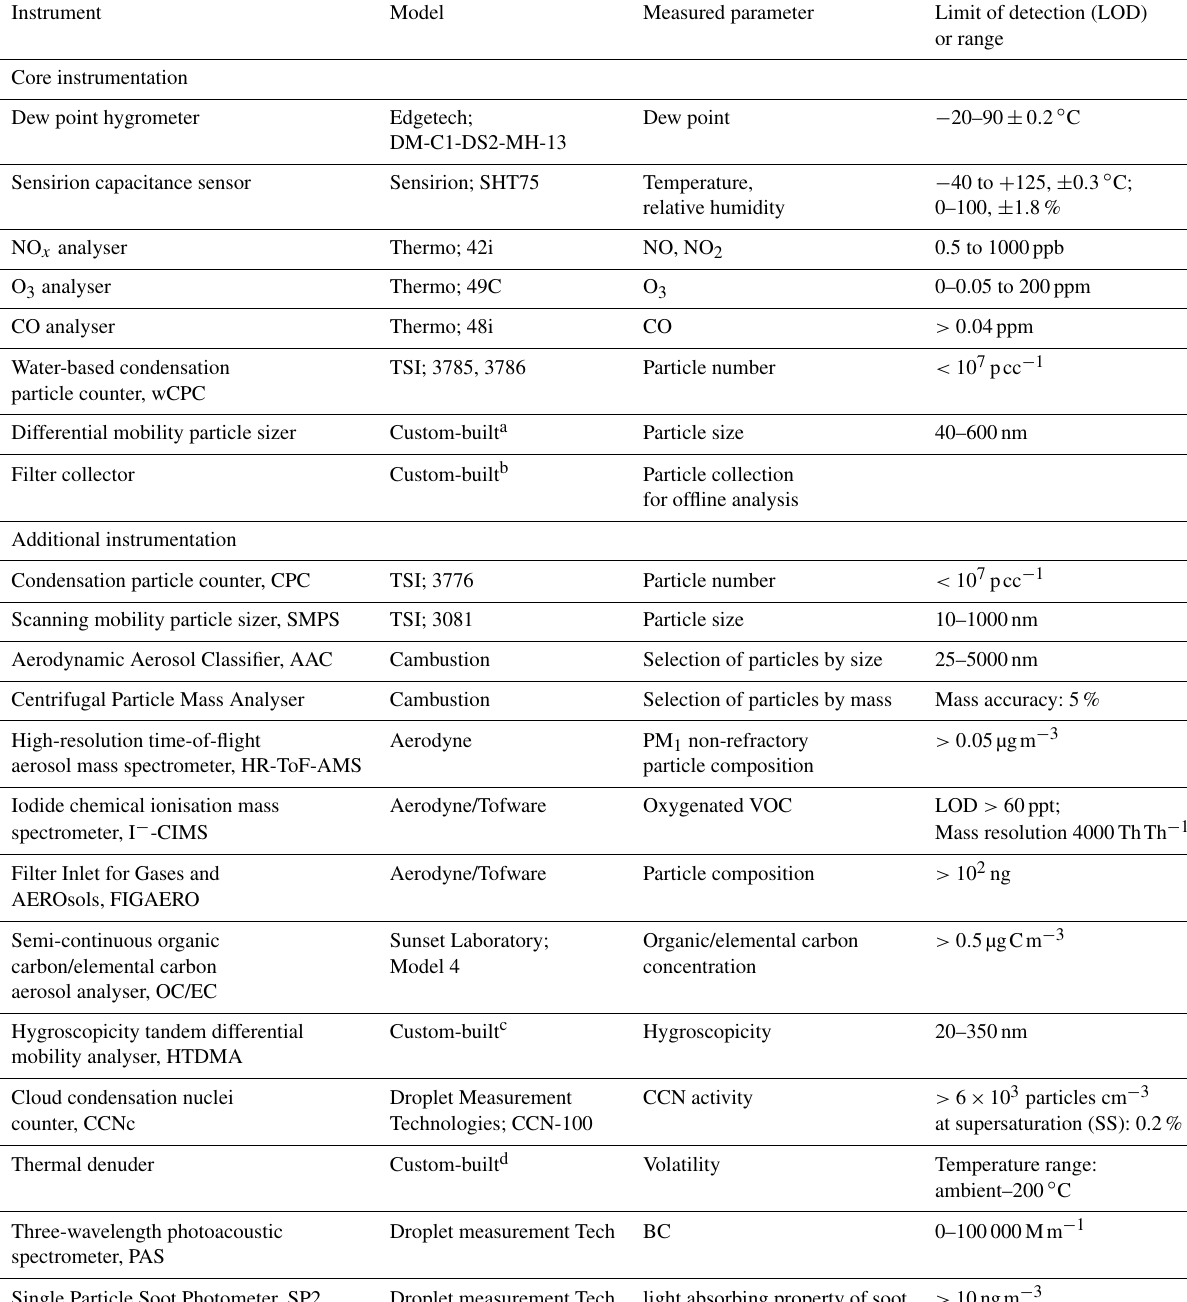
Table 1. List of the available instrumentation at the